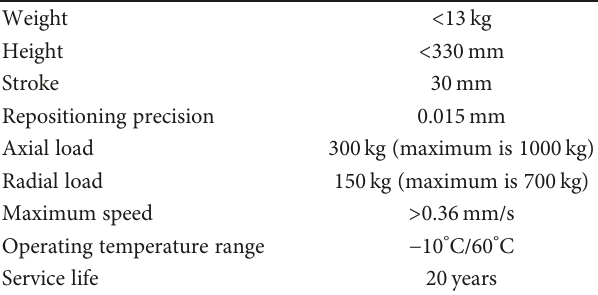
Table 8: Design parameters of Tianma